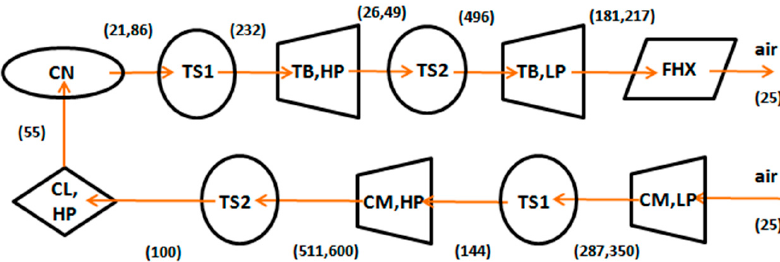
Figure A2. Temperature range of the A-CAES system in the base case scenario. Values in each bracket show minimum and maximum temperature. The cavern operates in 5–10 MPa range. The compressor and expander stages have equal pressure ratios.